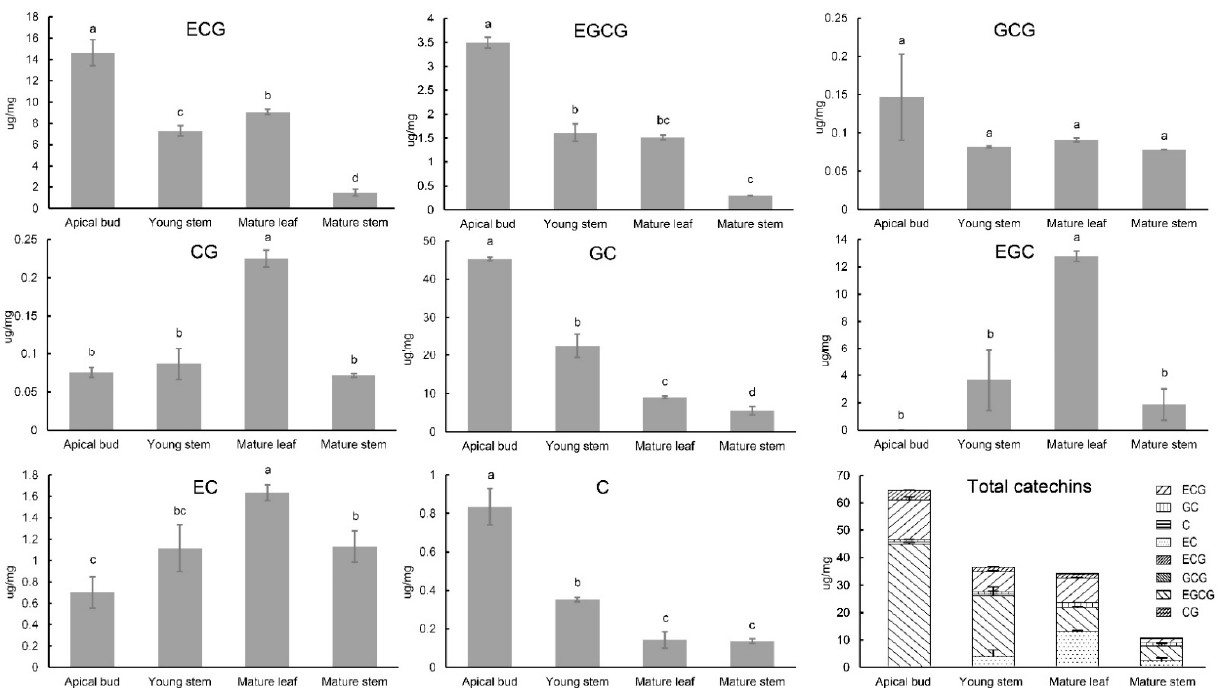
Figure 6. Catechins accumulation in different tissues of tea plants. C, catechin; EC, epicatechin; CG, catechin gallate; GC, gallocatechin; EGC, epigallocatechin; ECG, epicatechin gallate; EGCG, epigallocatechin gallate; GCG, gallocatechin gallate. Total catechins were calculated by the sum of all above seven catechins content. Statistically significant differences based on Student’s t -test, p < 0.05 are indicated by letters. And the same letter means insignificant changes, while the different letters between two bars mean significant change. Error bar is standard error. Each data contained three independently biological